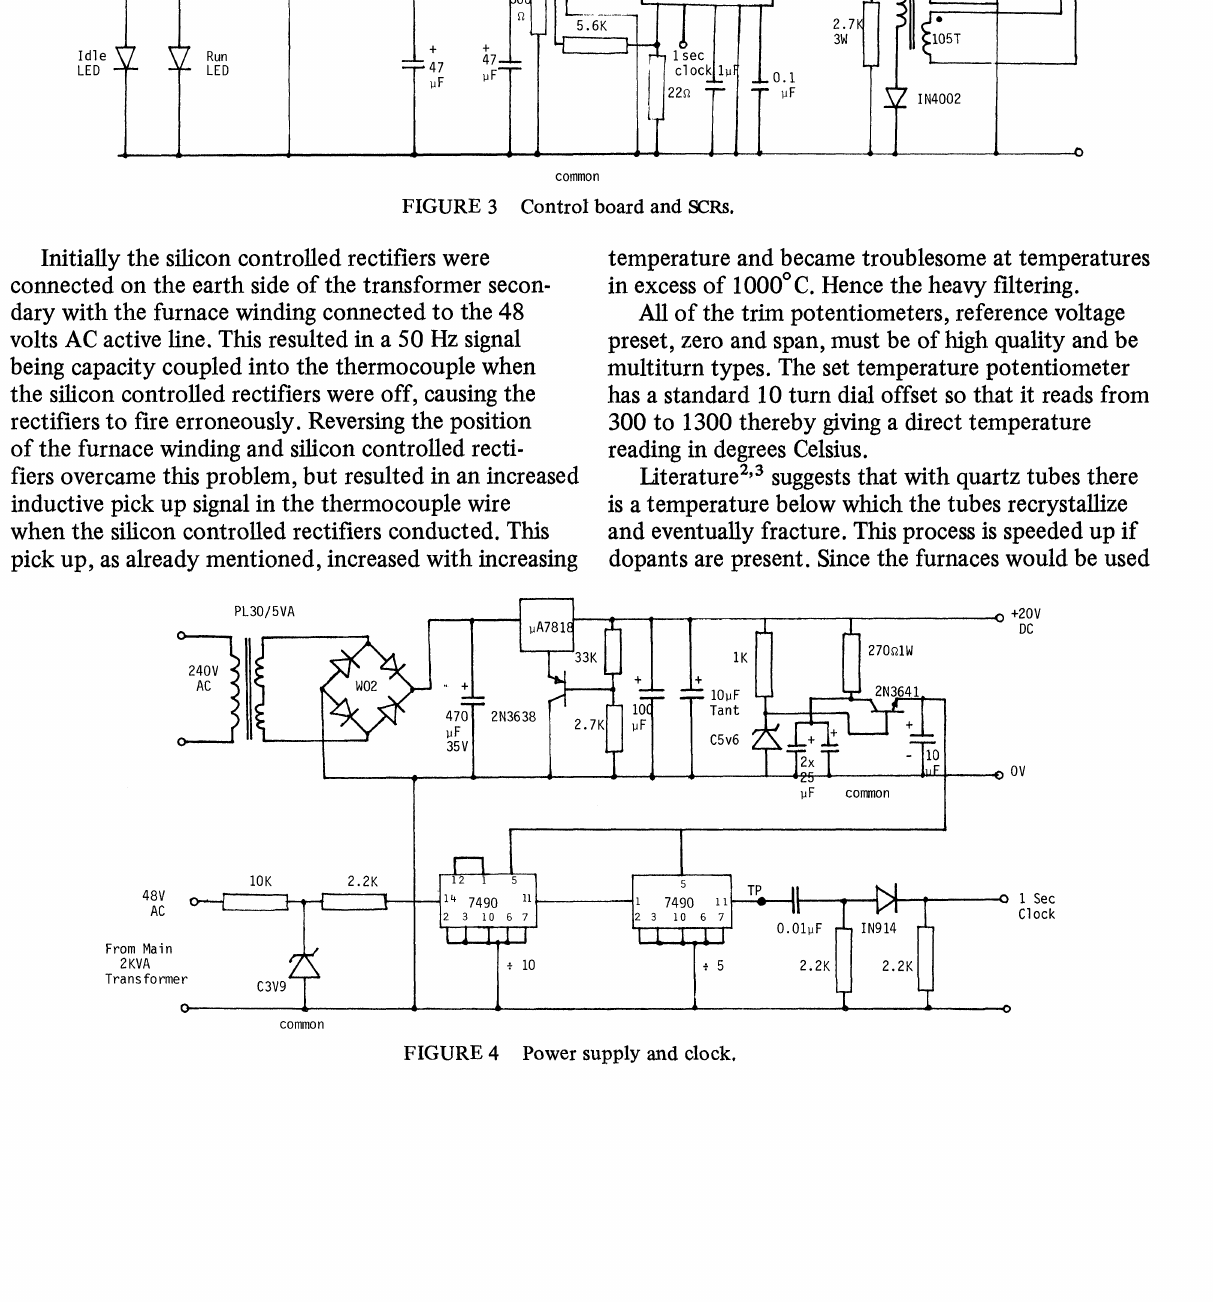
FIGURE 4 Power supply and